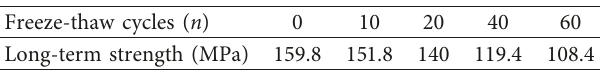
Table 6: Long-term strength of tuffaceous